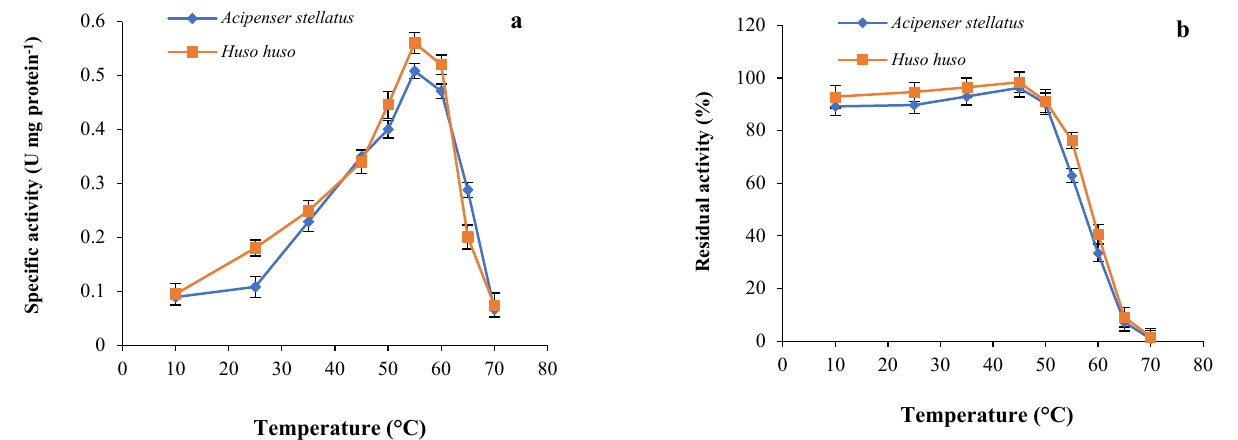
Figure 2. ( a ) Optimum temperature: the enzymatic activity of both trypsins was measured at different temperatures at pH 8.5 using BAPNA as a substrate; ( b ) thermostability: residual activity of both enzymes was determined at 55 °C and pH 8.5 after incubating at different temperatures for 30 min using BAPNA as a substrate.